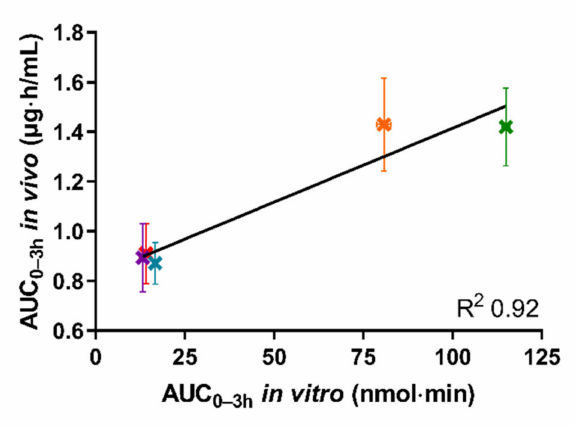
Figure 5. The correlation between in vitro AUC 0–3h of permeated cinnarizine in the lipolysis- permeation method and in vivo AUC 0-3h from the reference study of the SNEDDS 80% (green), su- perSNEDDS suspension (blue), superSNEDDS solution (purple), the Chasing principle (orange), and aqueous suspension (red). The in vitro data are presented as the mean ± SEM ( n = 12), and the in vivo data as mean ± SEM ( n = 6). Due to low variability of the in vitro data, these deviations are barely